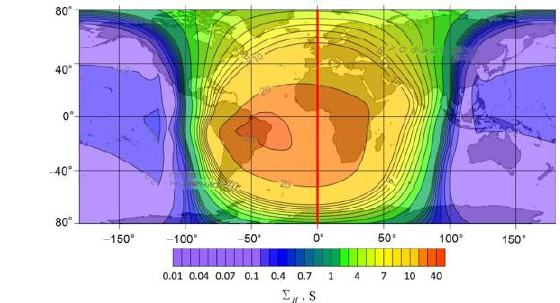
Figure 4. Spatial distribution of the electric field amplitude and its vectors (black arrows) in the lower ionosphere. The red vertical line shows the position of the subsolar meridian. Calculations of the disturbance of electromagnetic field and current were made using the model described in Sections 2 – 4 and Appendixes A and B. They were carried out using the Wolfram Mathematica system for analytical and numerical calculations. In most cases, the built-in tools of the system were used, such as procedures for analytical operations with matrices and the numerical solution of differential equations, both ordinary and with partial derivatives. The procedure for the numerical inversion of the Laplace transform was carried out using the Stehfest algorithm (see Appendix A for details). The calculations were carried out for the San Andreas fault area (USA, California) with coordinates 35°07 ′